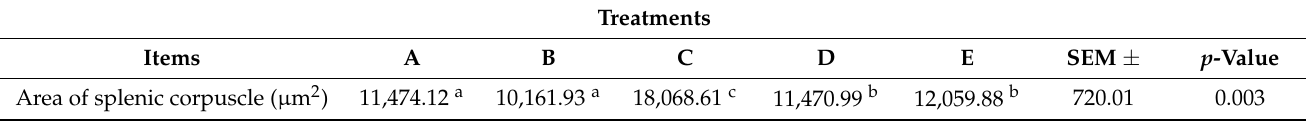
Table 7. GA decreased the area of splenic corpuscle in the